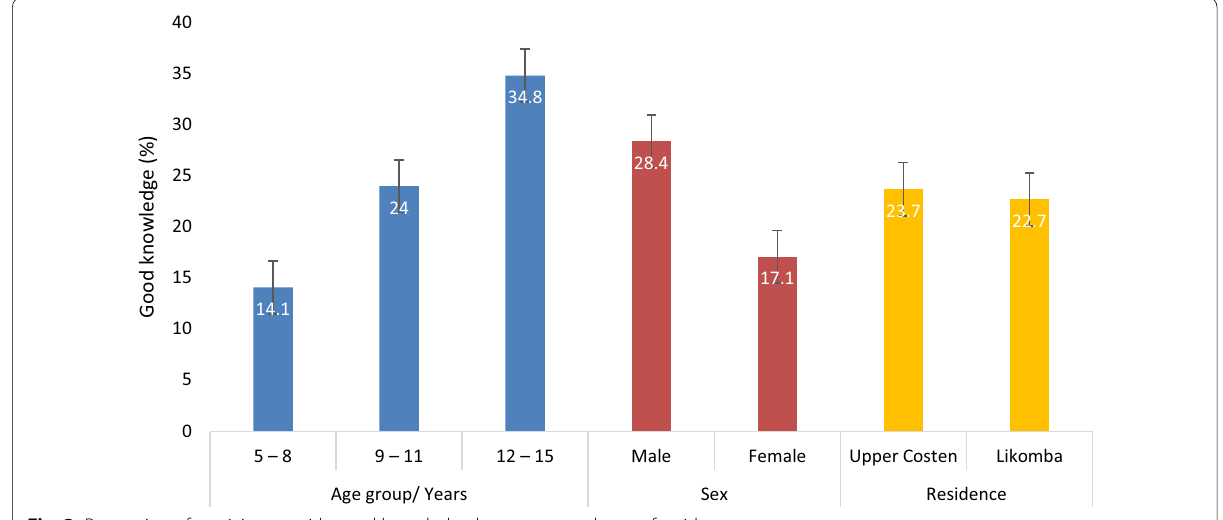
Fig. 3 Proportion of participants with good knowledge by age, sex and area of residence